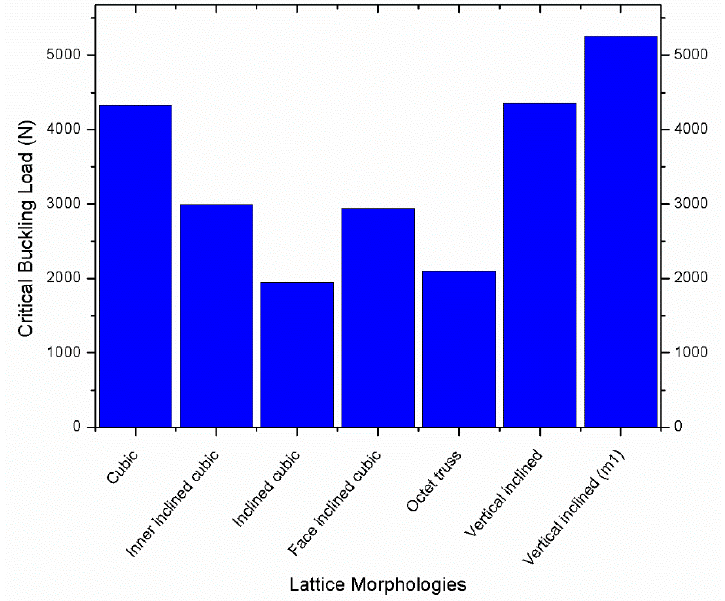
Figure 6. Critical buckling load of different lattice morphologies.